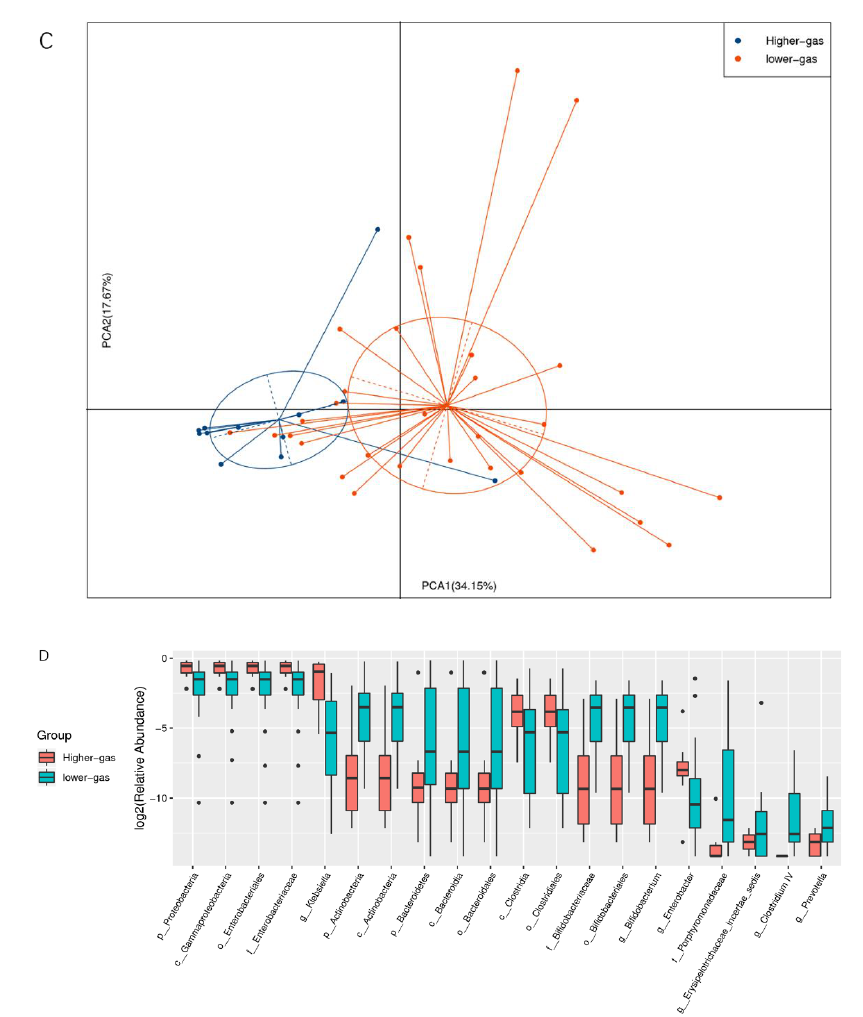
Figure 4. Analysis of differences in gas production between feeding methods and genus differences (( A ) heat map, ( B ) Boxplot, ( C ) PCA, ( D ) PC